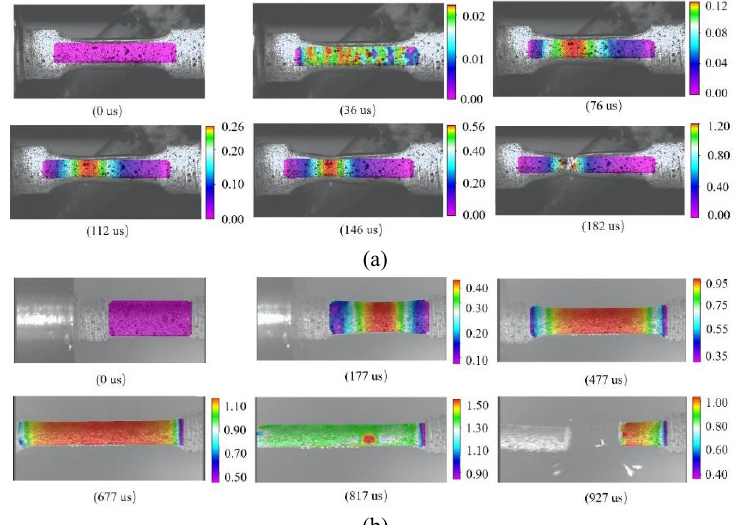
Fig.5 Dynamic deformation process with DIC at high strain rates of 1200-1900 /s. (a) Ti3Al2.5V (b) polycarbonate. Axial engineering strain filed is